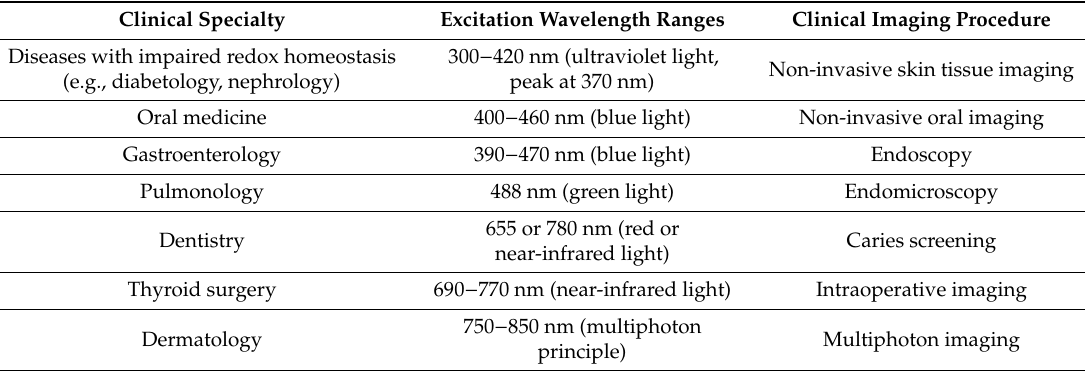
Table 1. Overview of the excitation wavelength used for the di ff erent clinical